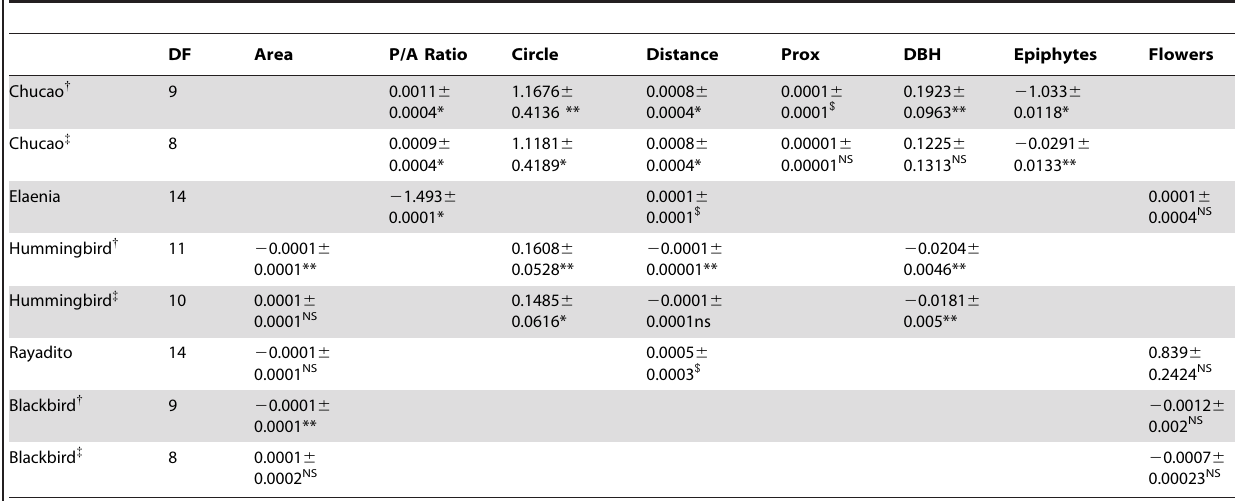
Table 1. Results of Generalized Linear Models for the effect of selected patch characteristics on patch-level bird density (parameter estimates 6 standard